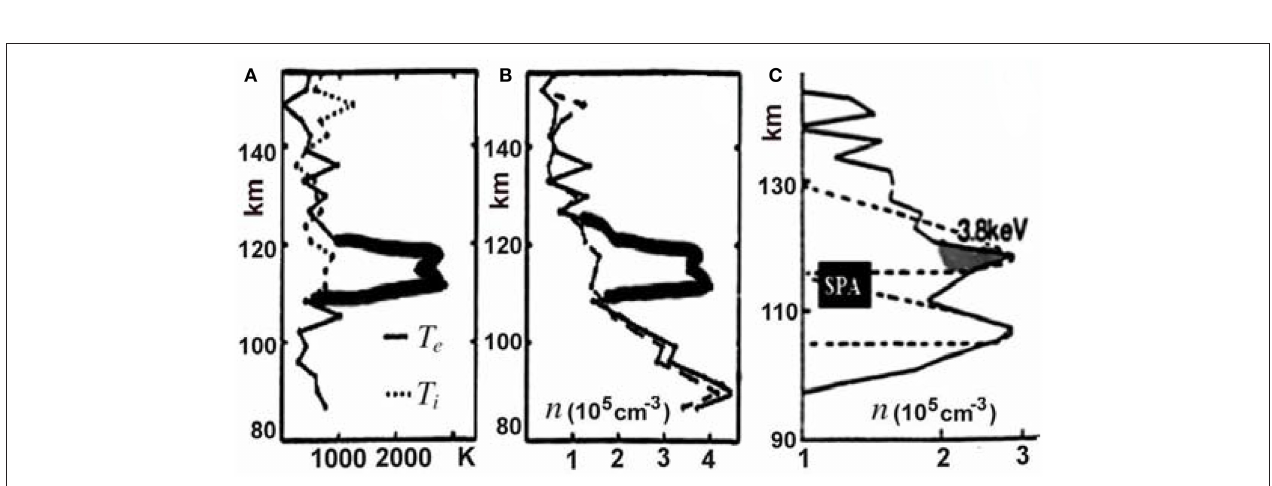
FIGURE 15 | Thin layers of the (A) elevated electron temperature and (B) electron density indicated by thick lines (after Schlesier et al., 1997); and (C) a double-peaked ionization profile in pulsating aurora. Dashed lines show the SPA profiles calculated for ε b permission from the American Geophysical